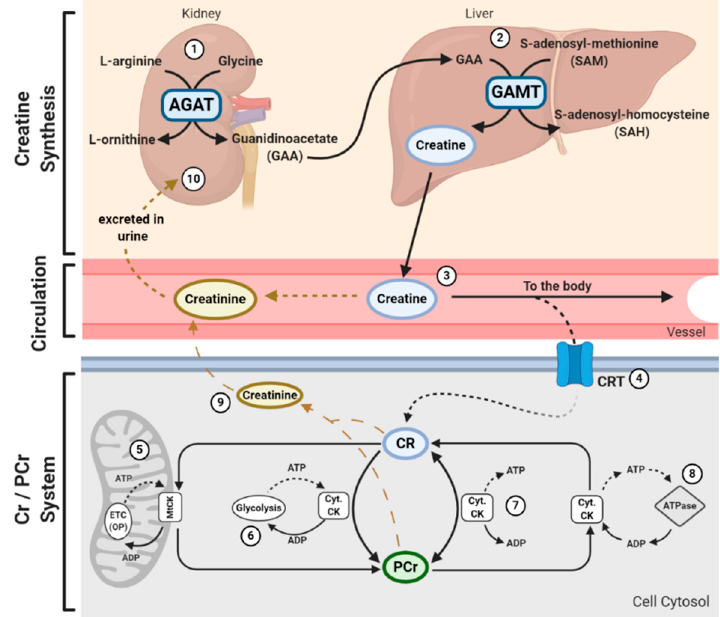
Figure 1 . Physiological Journey of Creatine: Synthesis of creatine (Cr) happens at a rate of ~1 g/day [7] via an interorgan process. (1) Within the kidneys, L- arginine: glycine amidinotransferase (AGAT) transfers an amidino group from L-arginine to glycine, resulting in the formation of L-ornithine and guanidinoacetate (GAA). (2) GAA is then transferred and processed in the liver. Guanidinoacetate N-methyltransferase (GAMT) transfers a methyl group from the methyl donor S-adenosylmethionine (SAM) to GAA, resulting in the formation of Cr and S-adenosylhomocysteine (SAH). SAH can thereon be hydrolyzed into homocysteine by S-adenosylhomocysteine hydrolase (not shown). (3) Cr is released from the liver into circulation, where Cr is transported to varying tissues such as the skeletal muscle, brain, kidney, and heart. (4) Cellular uptake of Cr is mediated by a creatine transporter (CRT), or SLC6A8 . Cr carries both positive and negative charges, and is transported via secondary-active transport, driven by a sodium/chloride-ATPase generated gradient. Once in the cell, Cr has a multitude of fates. (5) Cellular Cr can be transformed into phosphocreatine (PCr) by mitochondrial creatine kinase (mtCK) which is coupled to oxidative phosphorylation (OP) via the electron transport chain (ETC). (6) Cr can be converted into PCr by cytosolic creatine kinase (Cyt. CK) coupled to glycolysis. (7) The cellular Cr/PCr pool is utilized to maintain adenosine triphosphate (ATP)/ adenosine diphosphate (ADP) ratios through ATP resynthesis or “buffering.” (8) Cyt. CKs located throughout the cytosol can utilize the high-energy PCr stores to shuttle and utilize energy at sites of ATP demand, or ATP-dependent processes, via ATPase enzymes. Such processes include ATP-gated ion channels, ATP-regulated receptors, ATP-regulated ion pumps; contractile processes, cell motility, cell signaling, or organelle transport. (9) Both Cr and PCr are naturally metabolized into creatinine via a non-enzymatic, spontaneous reaction. Creatinine diffuses freely into the circulation to be transported to the kidneys. (10) Creatinine is fully excreted in the urine. Creatine and PCr, together with creatine kinase (CK) isoenzymes, function as quintessential high-energy compounds crucial for metabolism. In the case of low adenosine triphosphate